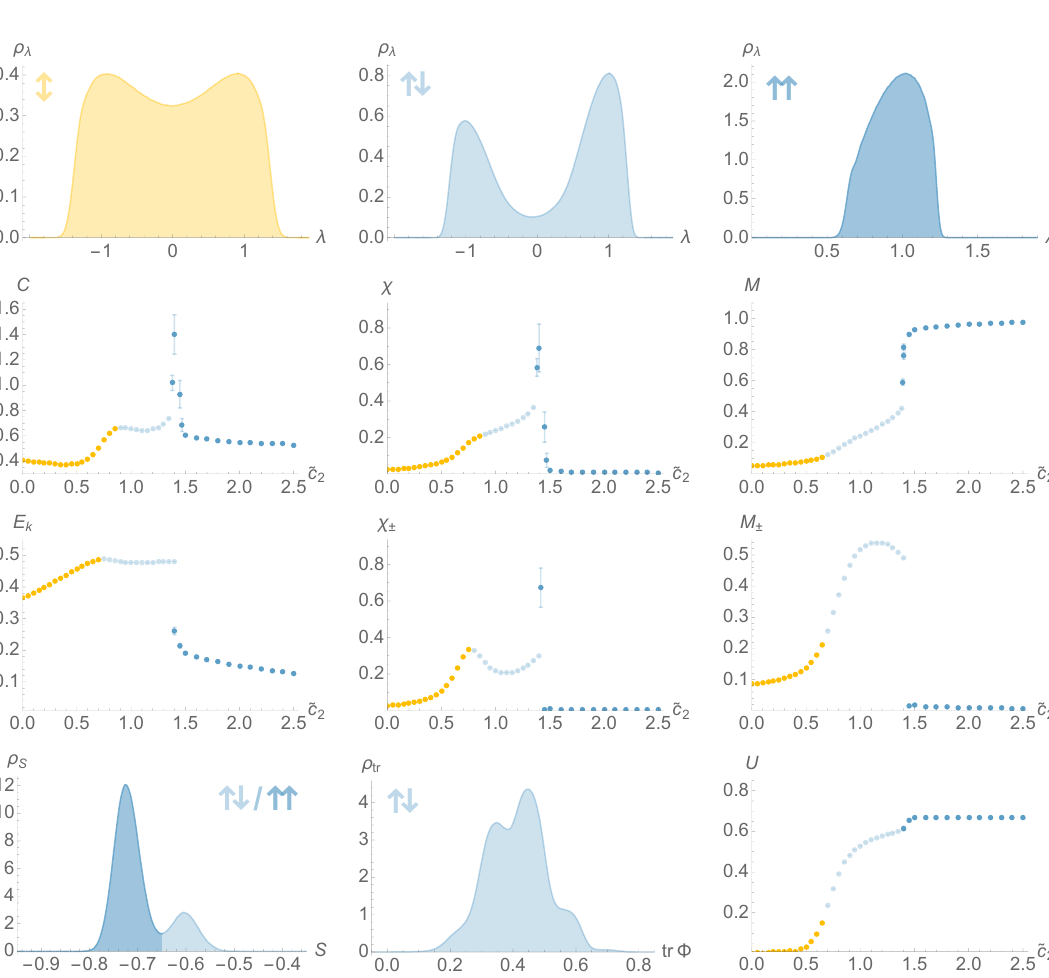
Figure 1 . Thermodynamic observables for N = 16 , c k = 1 , c r = 0 , c 4 = c 4 /N = 0 . 25 , as functions e of rescaled mass parameter c 2 = c 2 /N , with disordered phase colored in yellow/orange and ordered e phases in different shades of blue. Transitions are driven by changes in shape of the eigenvalue distribution ρ λ , as captured in top row at c 2 = 0 . 5 , 1 . 0 , 2 . 0 (left to right). We see two transitions e as two peaks in C and matching (would-be-) peaks in χ . We also easily see l and ↑↑ phases in plots of M and U , while the ↑↓ phase is clearly visible in staggered magnetization M ± and susceptibility χ ± and in E k . Energy distribution ρ S in the bottom left figure lives at c 2 = 1 . 4 , near the border e of two ordered phases, and represents two competing states with different energies each belonging to one of the phases. Jump between those states causes 1st order transition and prominent peaks in C and χ . The remaining shy peak in C signals 3rd order transition and it is similar in shape to figure lives at c 2 = 1 . 39 and reveals ↑↓ phase to be a mixture of different local minimum field e configurations with different ratios of positive and negative eigenvalues. Magnetization and traces p p are expressed in units of N h Tr Φ 2 i , eigenvalues in units of Tr Φ 2 /N , and S in units of c 2 / (4 c 4 ) . e e 2 Errorbars are mostly covered by data